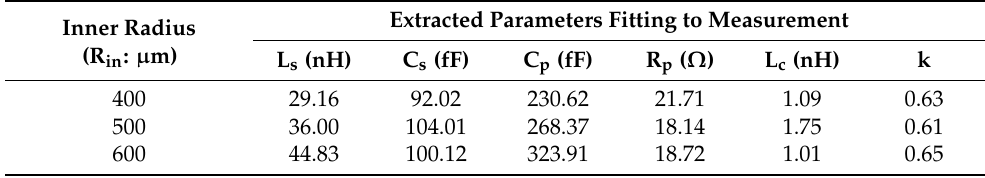
Table 2. Summary of model parameters for inductors with different inner